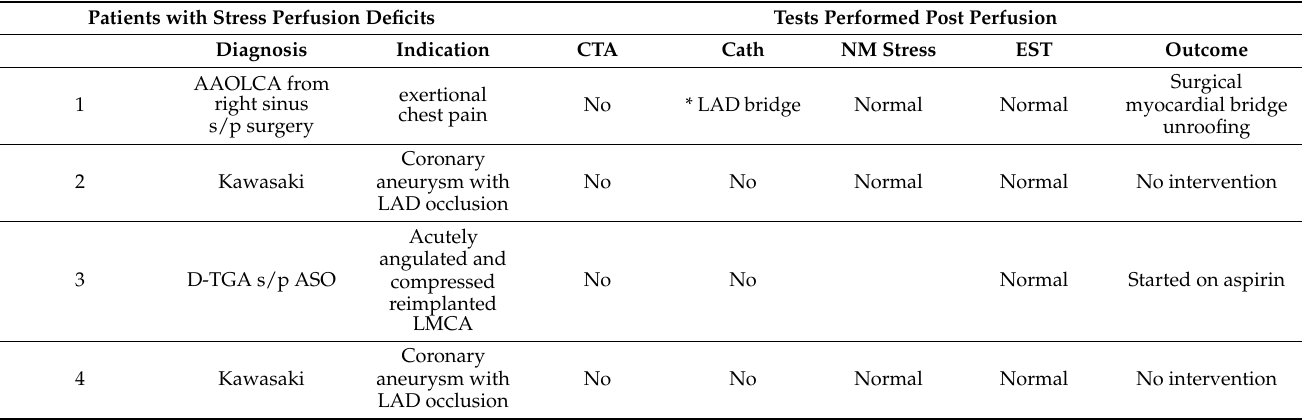
Table 4. Clinical follow up of 4 patients with reversible perfusion